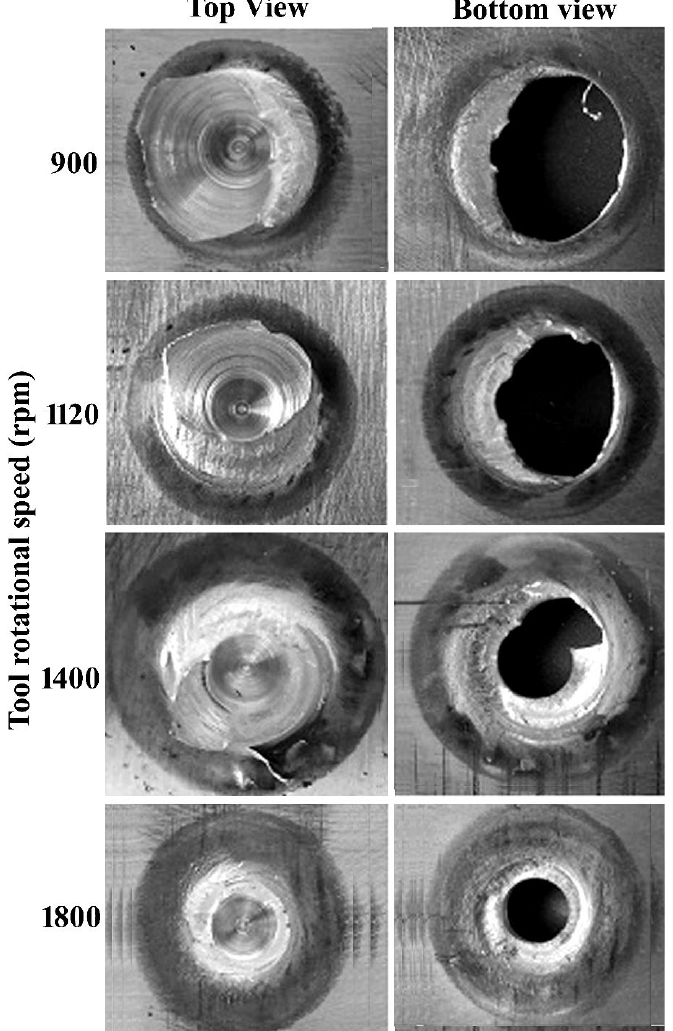
Figure 6. Macroscopic appearance of different modes of fracture made by the C-FSSW.